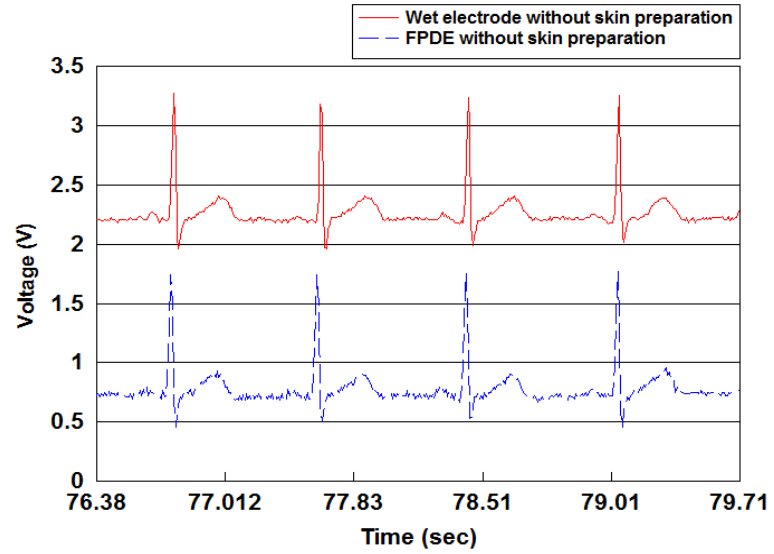
Figure 10. ECG signals detected by the proposed FPDE and wet